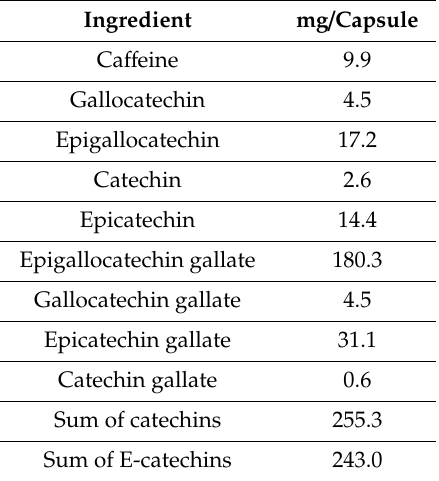
Table 1. Phytochemical characterization of deca ff einated green tea extract (dGTE) product used in the